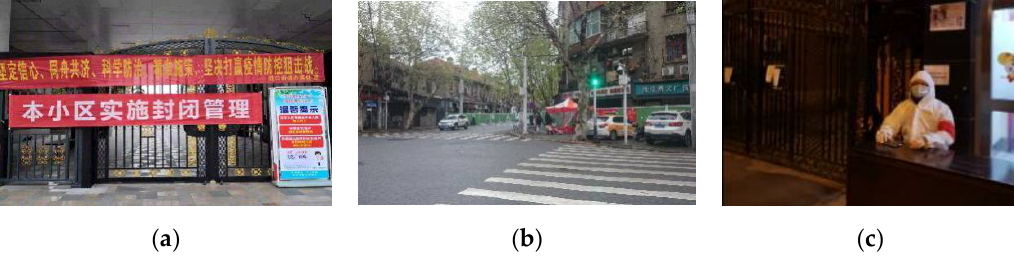
Figure 16. The epidemic prevention in communities (( a ) closed management of all neighborhoods ;( b ) physical isolation of open neighborhoods; ( c ) the communists’ jobs in communities).